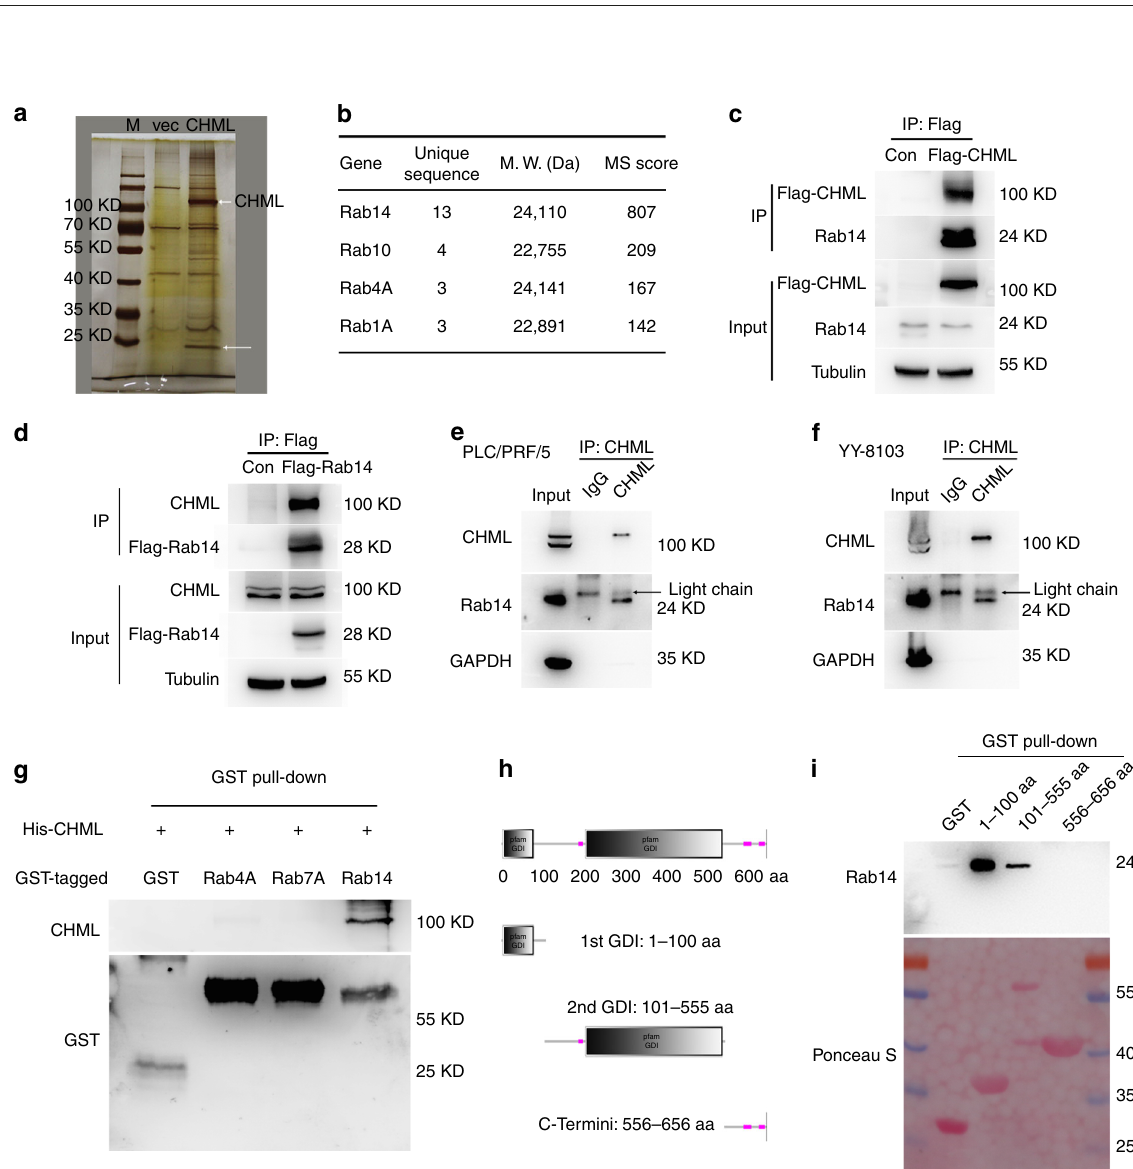
Fig. 3 Knockdown of CHML decreased cellular migratory and invasive abilities. a , c Western blot analysis of the knockdown ef fi ciency of CHML in HCC cell line CSQT-2 (a) and LM3 (c). b , d Boyden chamber and invasion assay are conducted to detect the migration and invasion abilities of control cells and CHML-knockdown CSQT-2 cells ( b ) and LM3 cells ( d ). Each representative image is shown. Quantitative blot analysis was shown on the right. Data are shown as the mean ± s.e.m., *** P < 0.001 by two-tailed unpaired Student ’ s t -test. e Left: representative images showing luciferase expression from intrahepatic tumors of both CSQT-2 control and shCHML group. Right: quanti fi cation of luciferase expression of intrahepatic tumors. * P < 0.01, Student ’ s t -test. f Livers of both control and shCHML groups resected from intrahepatic metastasis mouse model. Tissues are photographed, fi xed, and stained with hematoxylin and eosin (HE). Scale bar, 60 μ m. *** P < 0.001 by two-tailed unpaired Student ’ s t -test. g Left: representative images showing luciferase expression from lung metastasis of both CSQT-2 control and shCHML group. Right: quanti fi cation of luciferase expression of lung